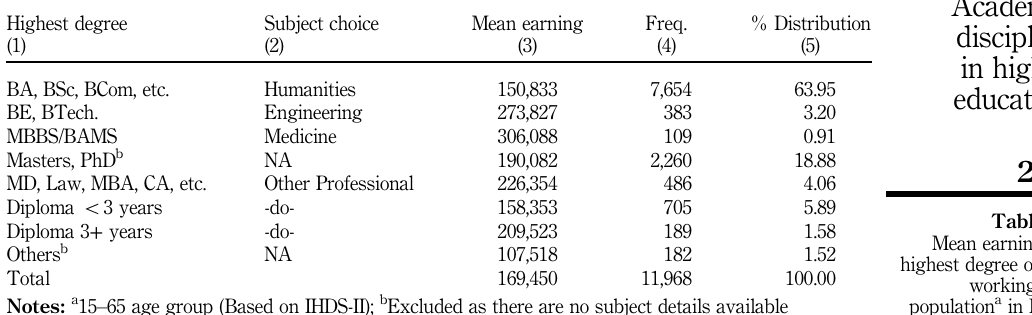
Table II. Mean earning